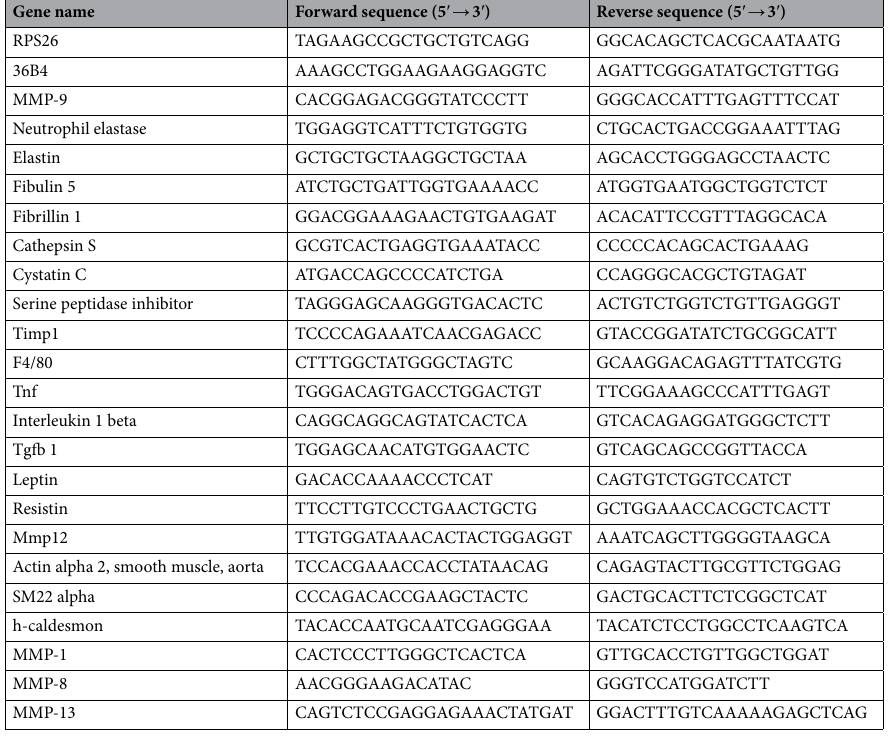
Table 1. Sequences used for